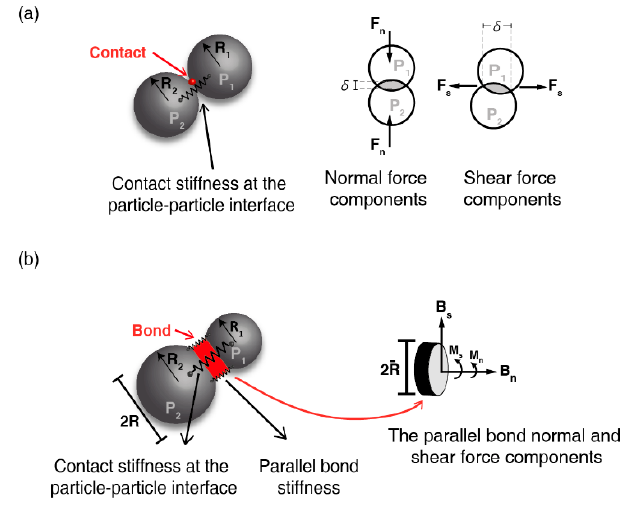
Figure 1. ( a ) An illustration of particles interaction according to the Hertz–Mindlin contact model. (Left) The contact point is illustrated as a red sphere and the contact stiffness as a spring. R 1 and R 2 represent the radii of particles P 1 and P 2 , accordingly. (Right) A 2D cross section of the acting normal ( F n ) and shear ( F s ) forces and the particle’s overlapping δ . ( b ) An illustration of particles interaction according to the linear parallel-bond contact model. (Left) In addition to a contact at the interacting point of two particles (contact stiffness presented as a spring), a bond is implemented as a cylindrical disk (in red), and its interaction is illustrated by two parallel springs. R 1 and R 2 represent the radius of particles P 1 and P 2 , accordingly. (Right) A 3D illustration of the bond’s normal ( B n ) and shear ( B s ) forces and the moments ( M n and M s ) that result from the applied force. The size of the applied bond is according to the average radius of the two interacting particles and represented as an average 2 R .